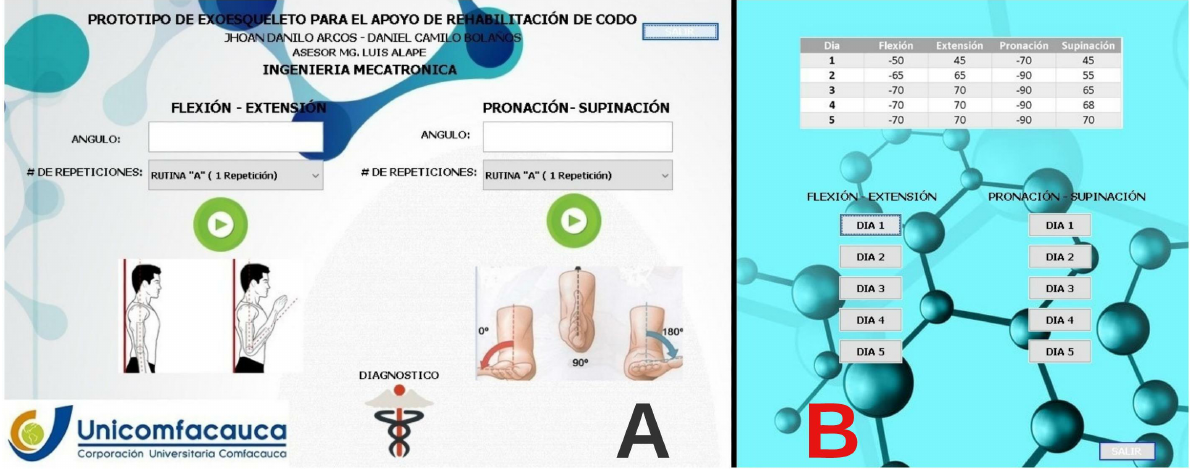
Figure 6. Graphical interface of the shoulder rehabilitation orthosis for the health care professional.